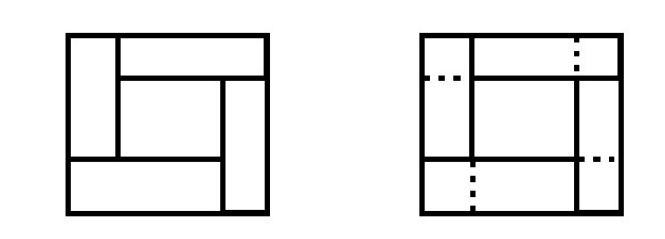
Figure 1: A partition being